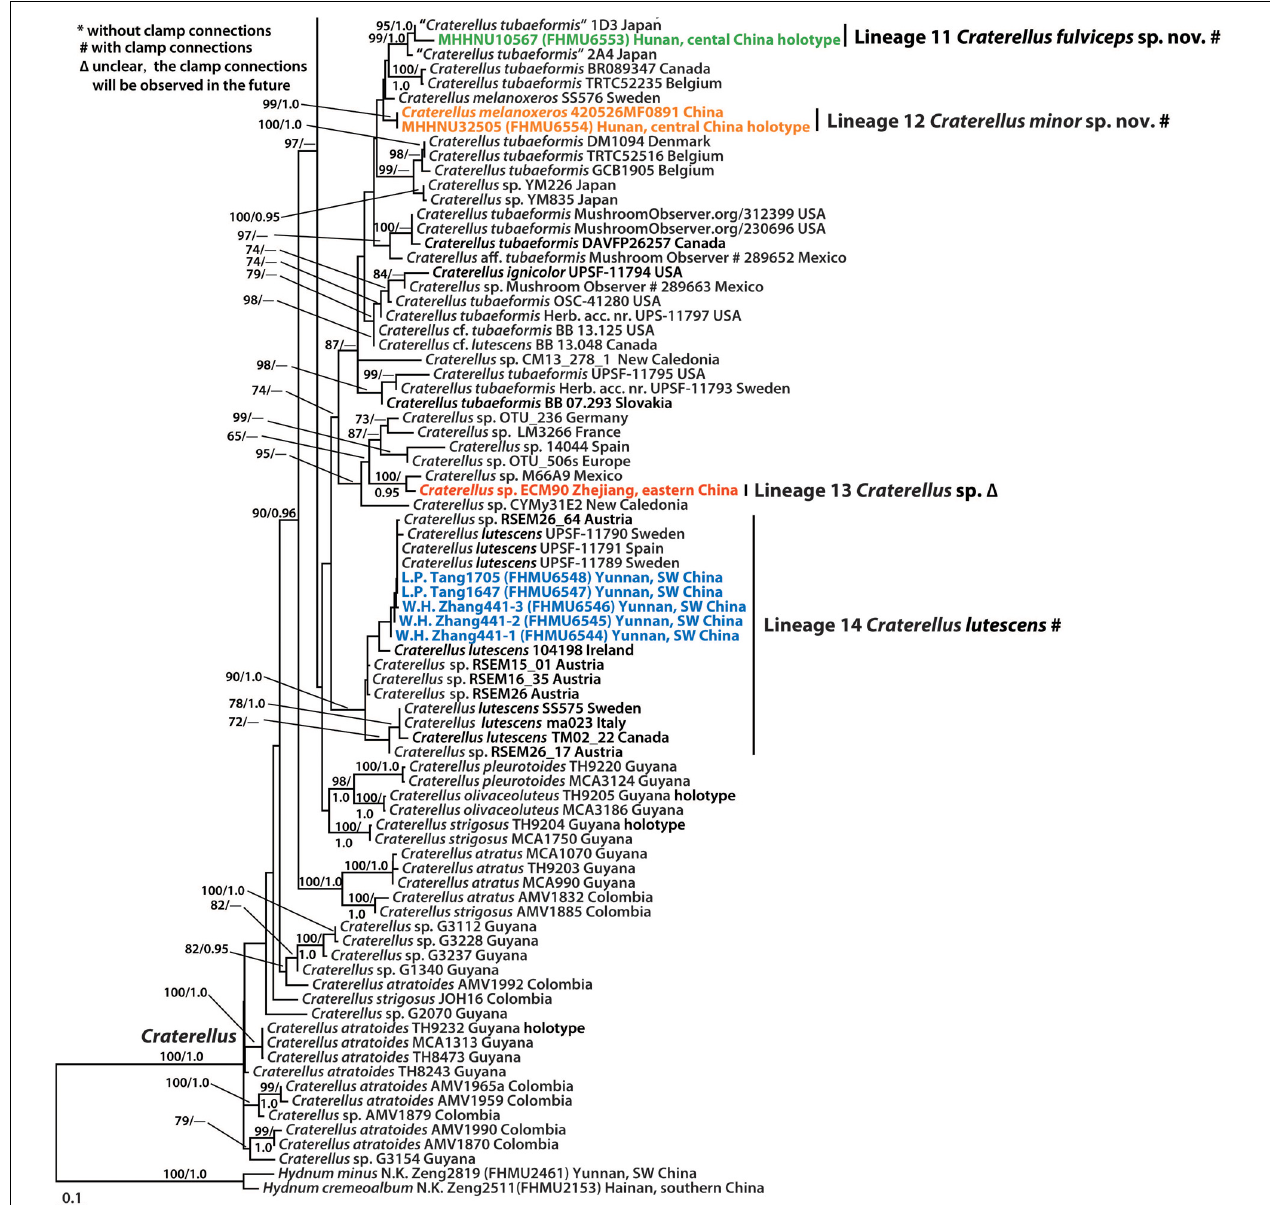
FIGURE 2 | Phylogram inferred from a combined dataset (28S + ITS) of Craterellus using RAxML. RAxML bootstrap percentages (BS ≥ 70%) and Bayesian posterior probabilities (PP ≥ 0.95) are indicated above or below the branches as